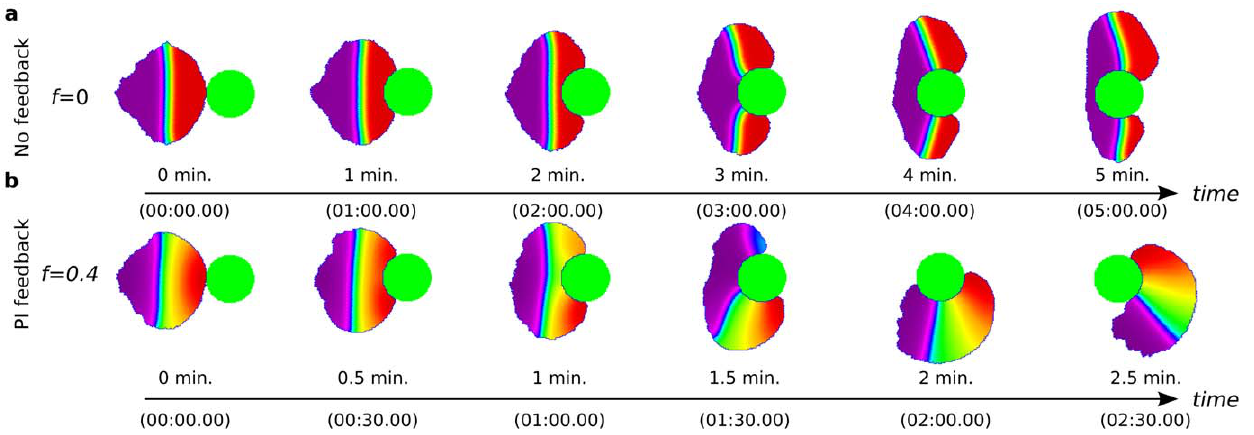
Figure 8. Response of a cell with and without PIs to obstacles in its path. As in Fig. 7, the cell is initially polarized and moving to the right until it encounters an obstacle (static green circular object). ( a ) Without feedback from PIs ( f ~ 0 ) the cell has difficulty resolving the competition between two nascent ‘‘fronts’’ which embrace the object. ( b ) The cell with feedback from PIs ( f ~ 0 : 4 ). The cell is able to move around the object smoothly. (See also Video S10.)